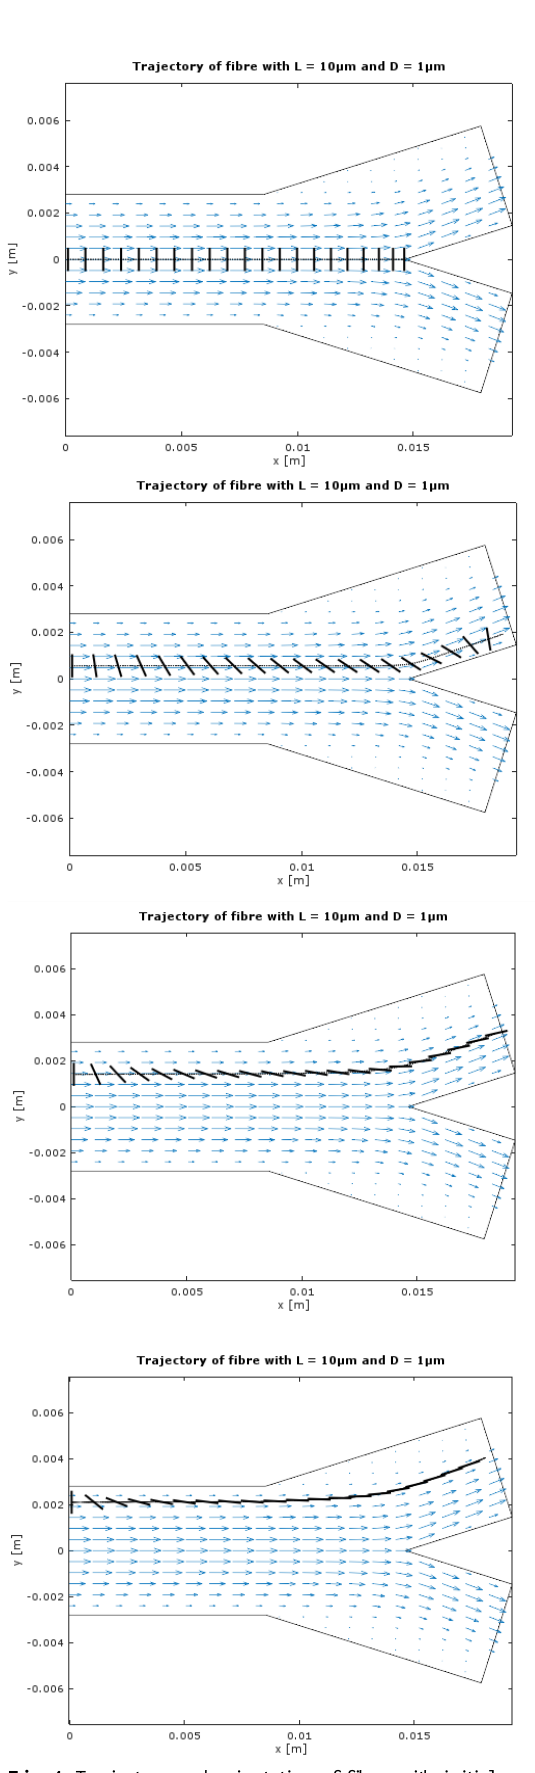
Fig. 4. Trajectory and orientation of fibre with initial positions of y/H = 0, y/H = 0.2, y/H = 0.5 and y/H = 0.75, respectively.